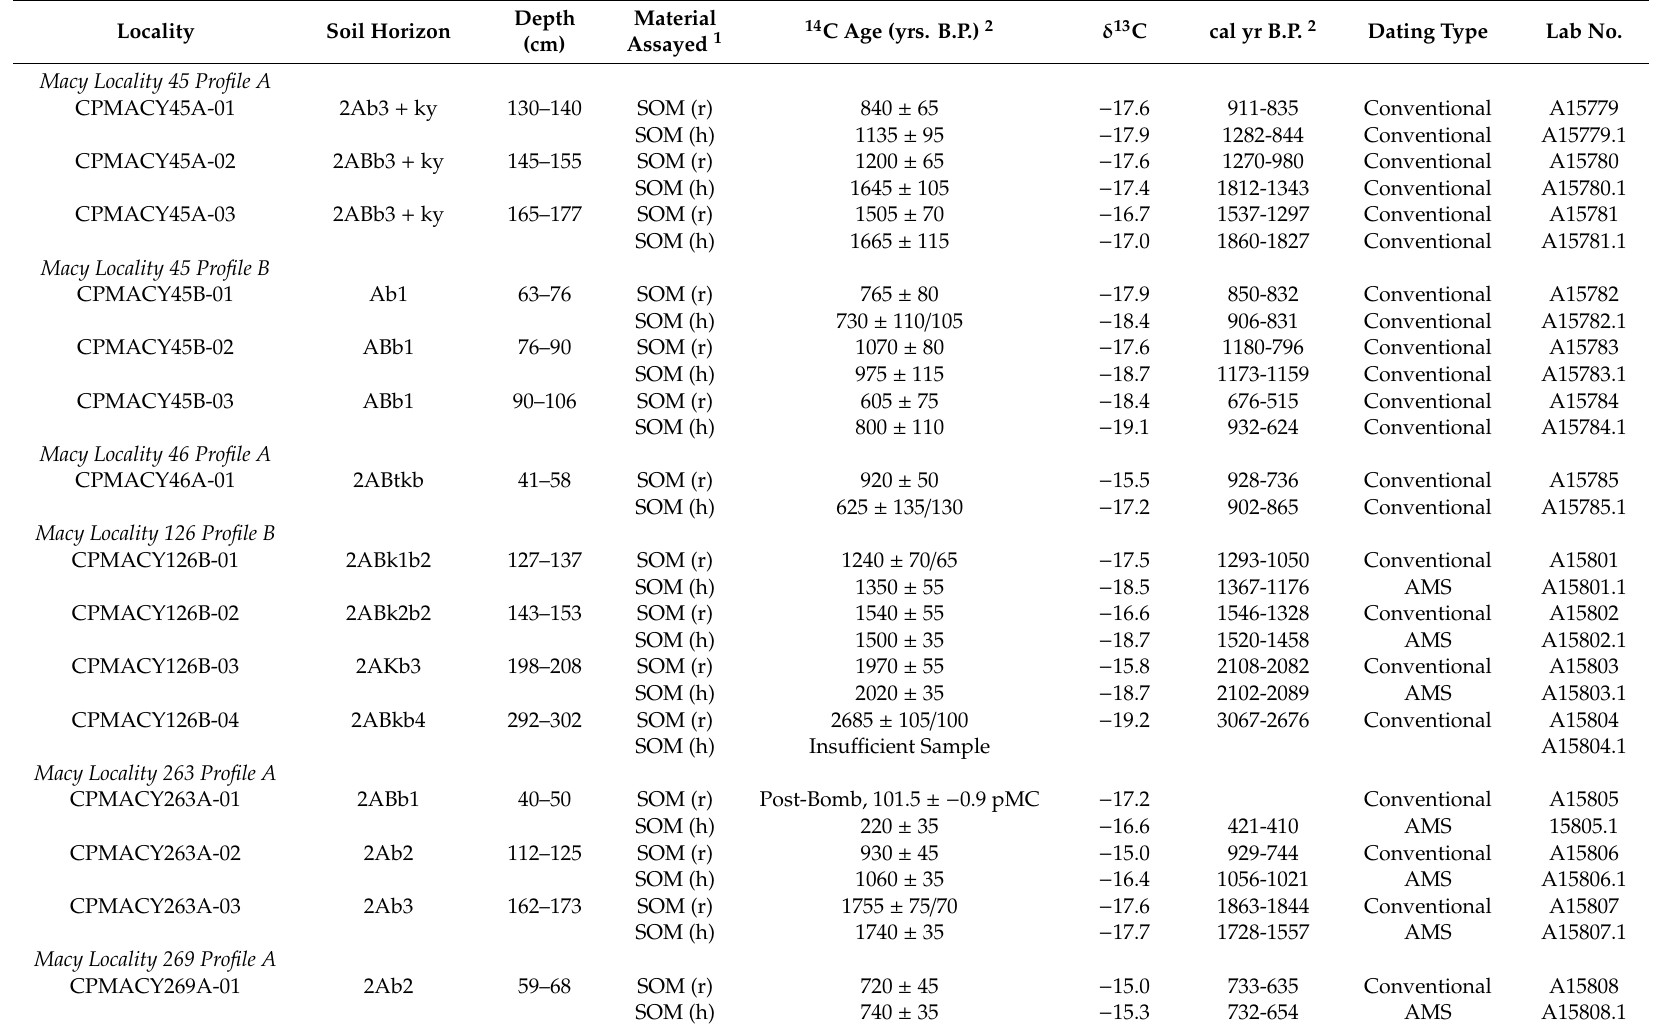
Table 1. Radiocarbon ages determined on soil organic matter for the study area, listed by